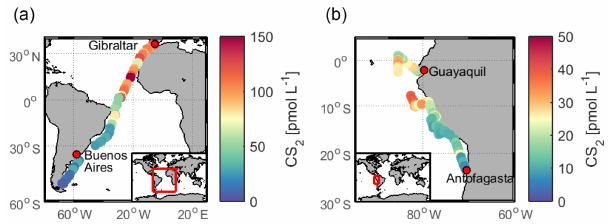
Figure 5. Measured concentration of CS 2 in surface waters during (a) ASTRA-OMZ in the eastern Pacific Ocean and (b) TransPE- GASO in the Atlantic